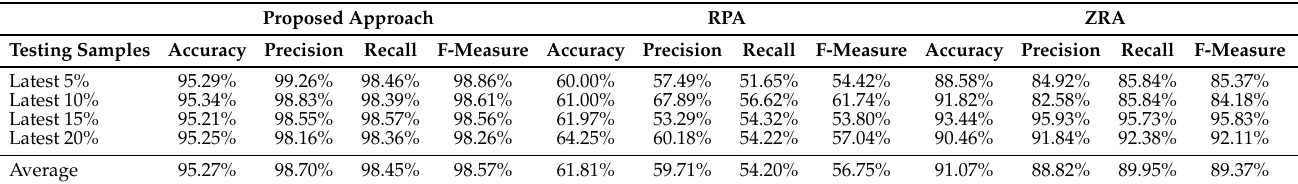
Table 2. Comparison against baseline